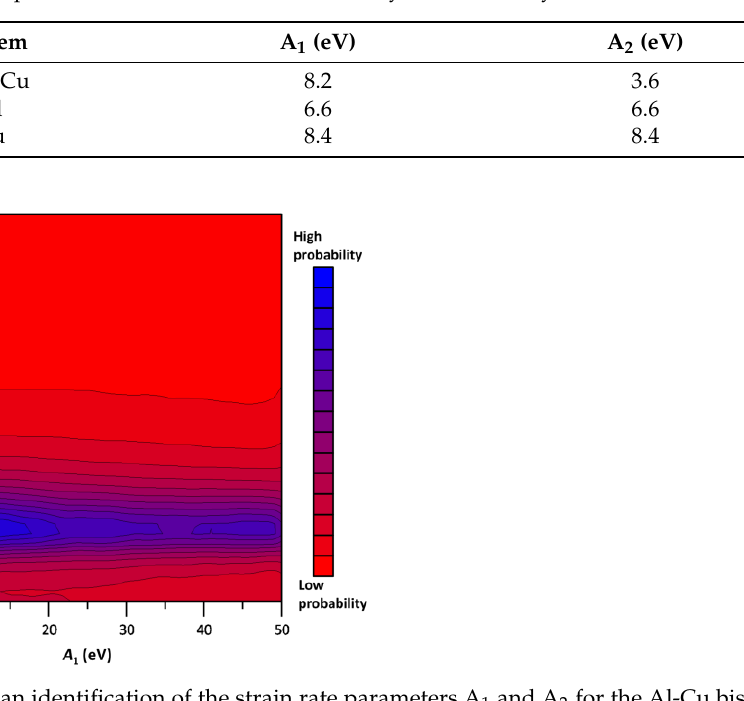
Table 1. Identified parameters of the strain rate sensitivity for different systems.